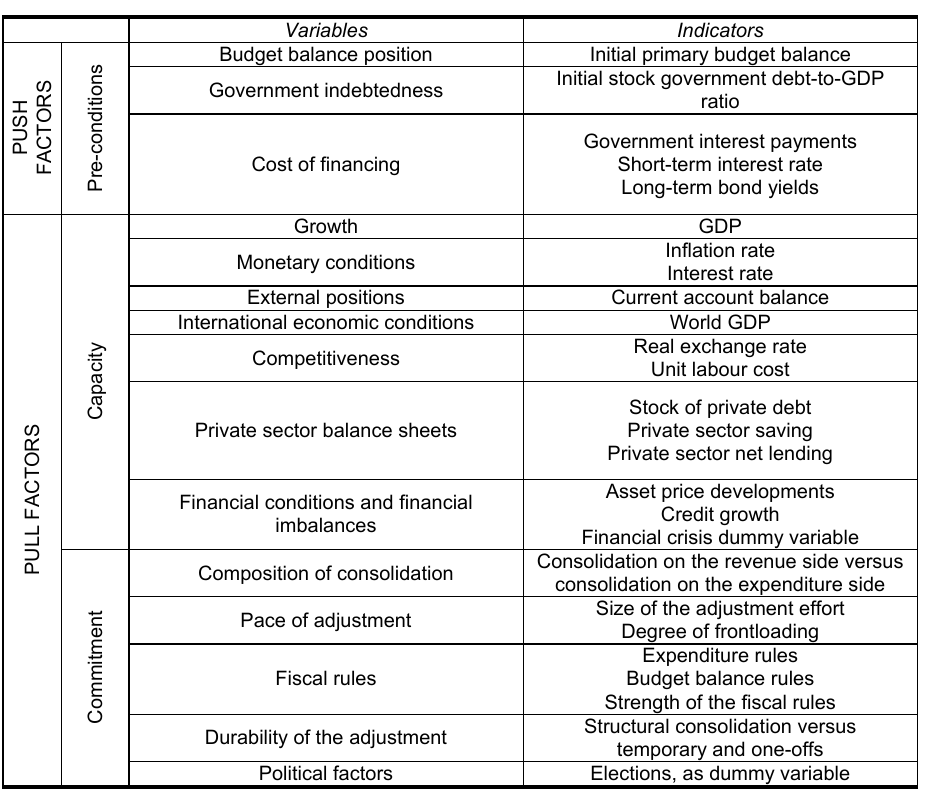
Table 1: Candidate determinants explaining the length of fiscal consolidation